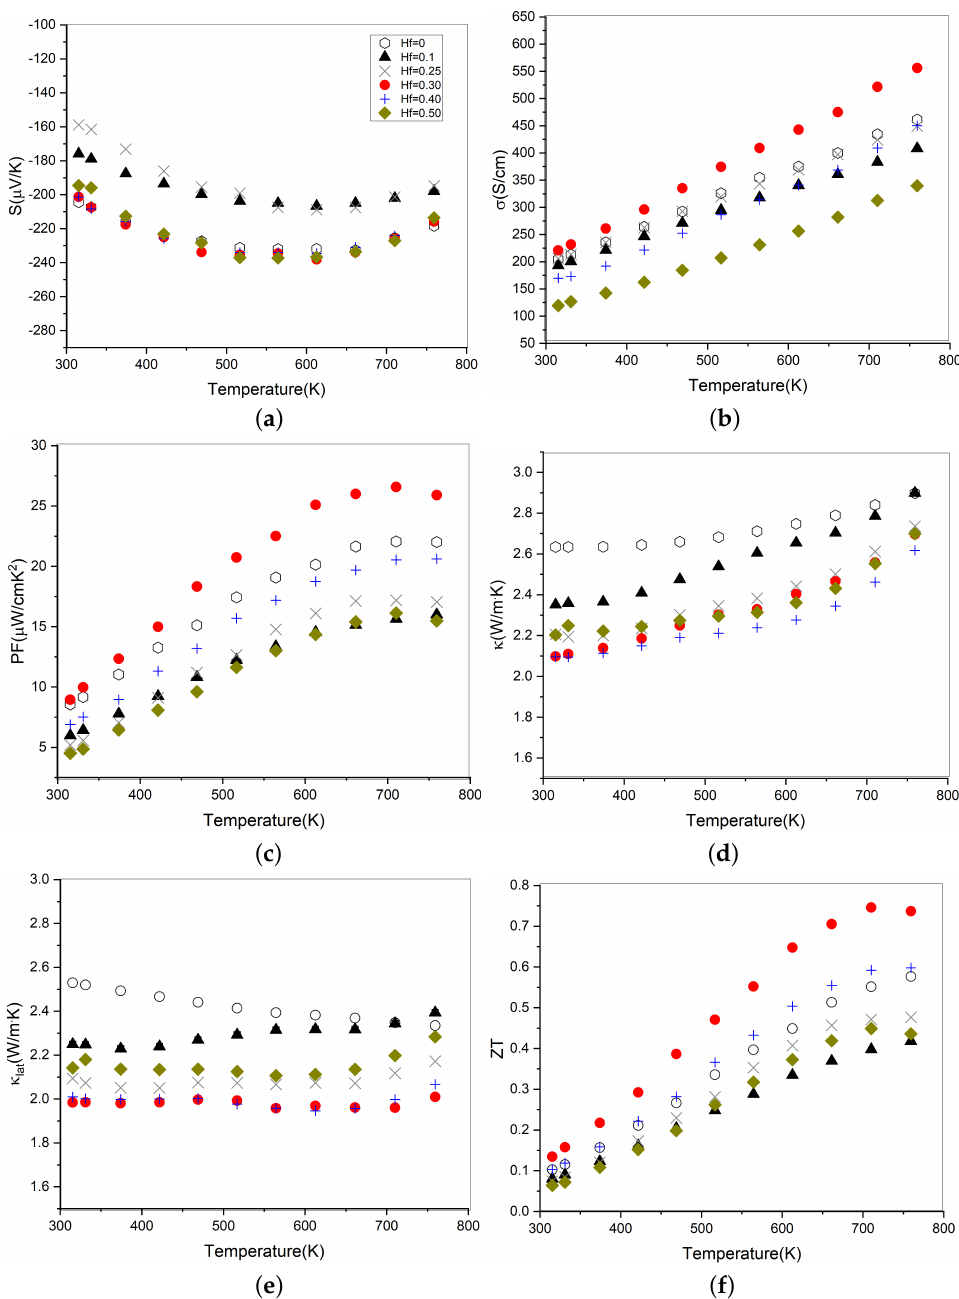
Figure 8. ( a ) Seebeck Coefficient, ( b ) Electrical conductivity, ( c ) Power factor, ( d ) Thermal conductivity, ( e ) Lattice thermal conductivity, and ( f ) Figure of merit of the (Ti 0.4 Zr 0.6 ) 1 − y Hf y NiSn